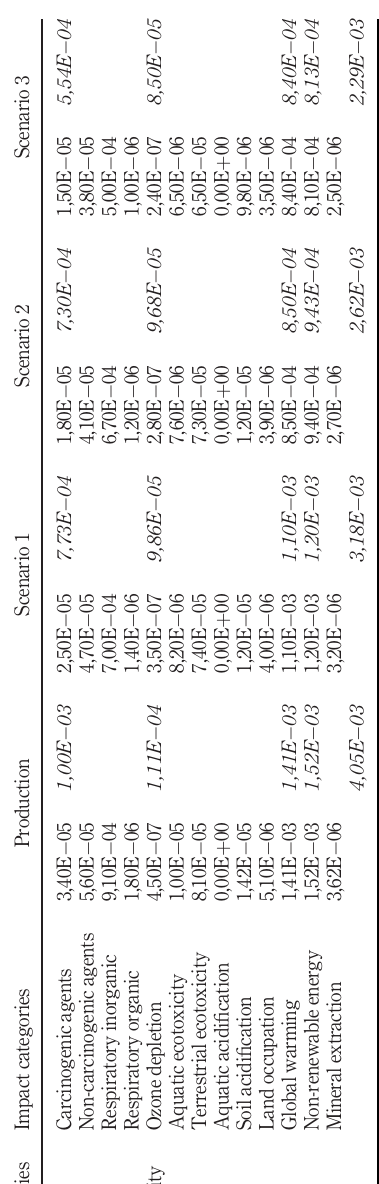
Table II. LCA analysis